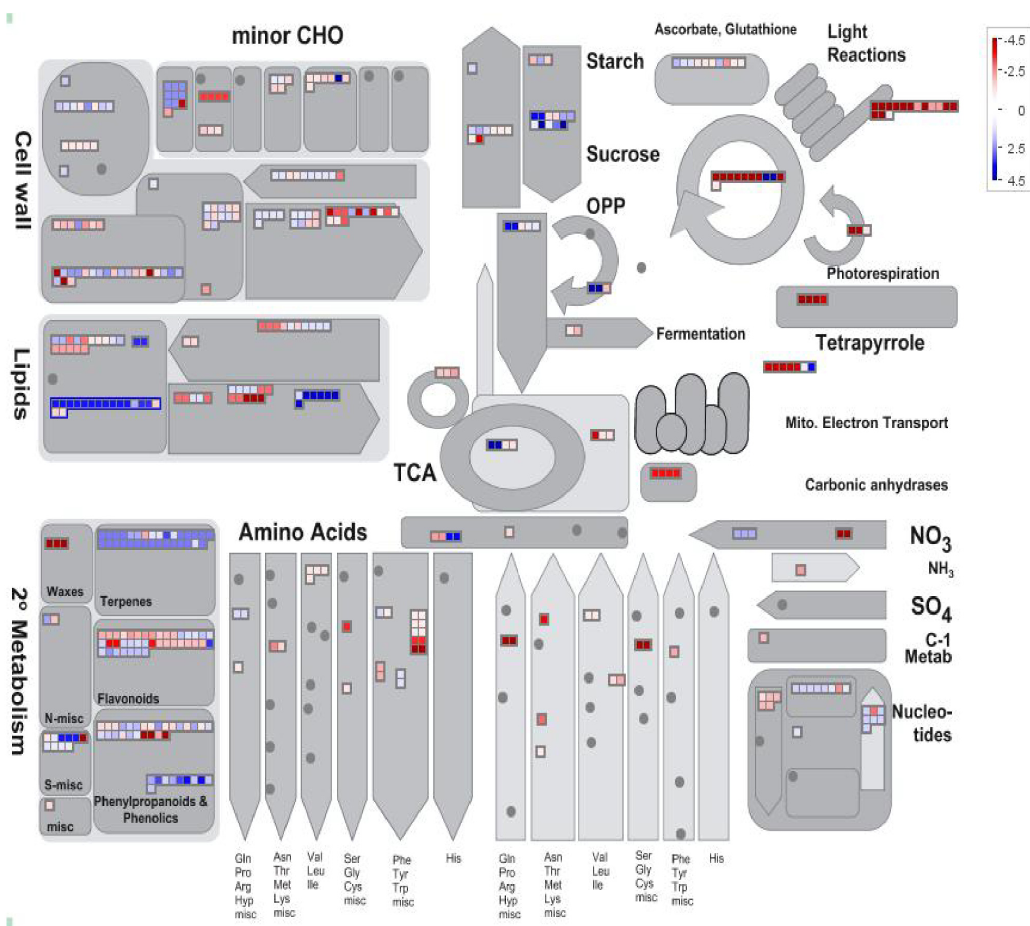
Fig 5. Metabolic pathways overview of DEGs in T . aestivum under salt stress using Mapman. blue: up-regulated genes and red: down-regulated genes.